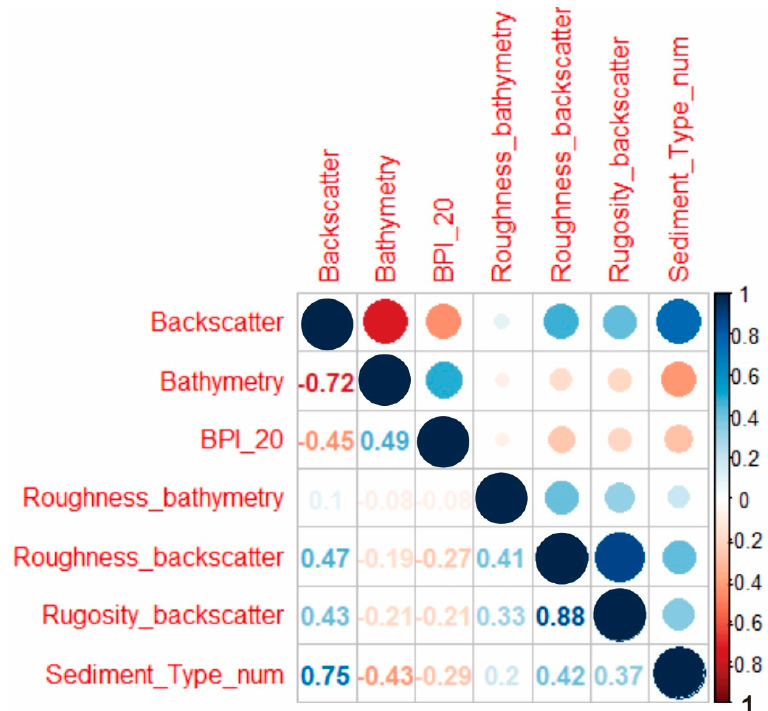
Figure 6. The correlation plot is showing the relationship between all the features with sediment types. Blue color means a positive relationship, but red color indicates a negative connection. Sediment_Type_num: 0 is mud, and 1 is sand. Table 2. Output from Random Forest selection algorithm. The first four bold scores (all greater than the threshold, which we defined as 1.5) are the most important features to identify sediment types.